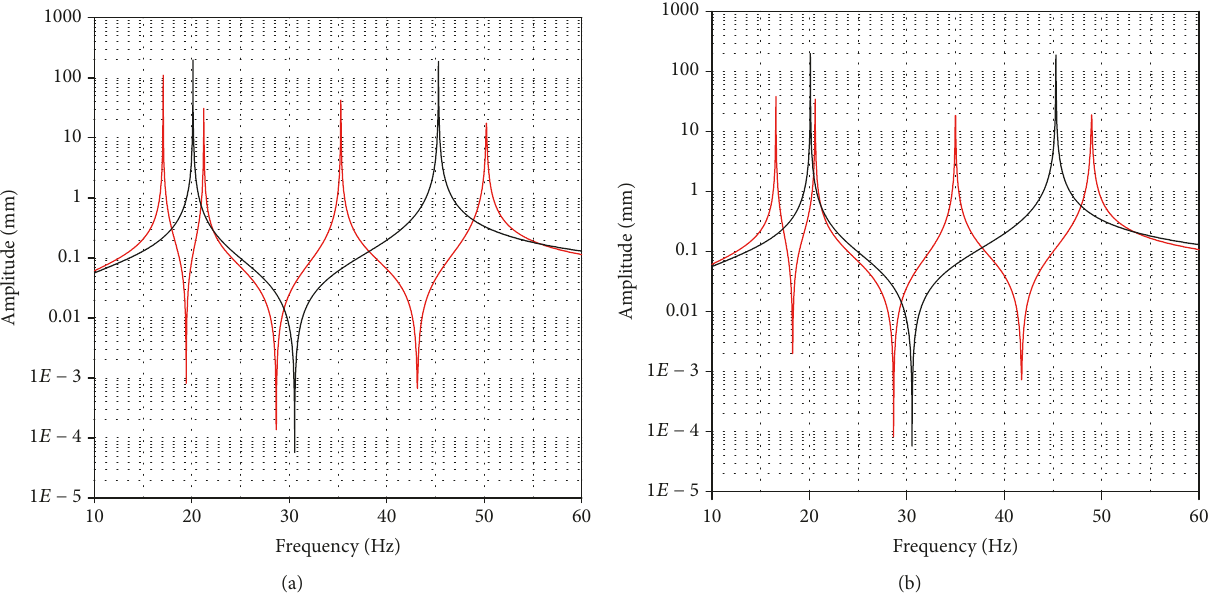
Figure 9: Frequency response functions of the plate with the TMDs: (a) with the TMDs tuned individually and (b) with the TMDs tuned for both bending and torsion (Key: black line, Primary: red line,